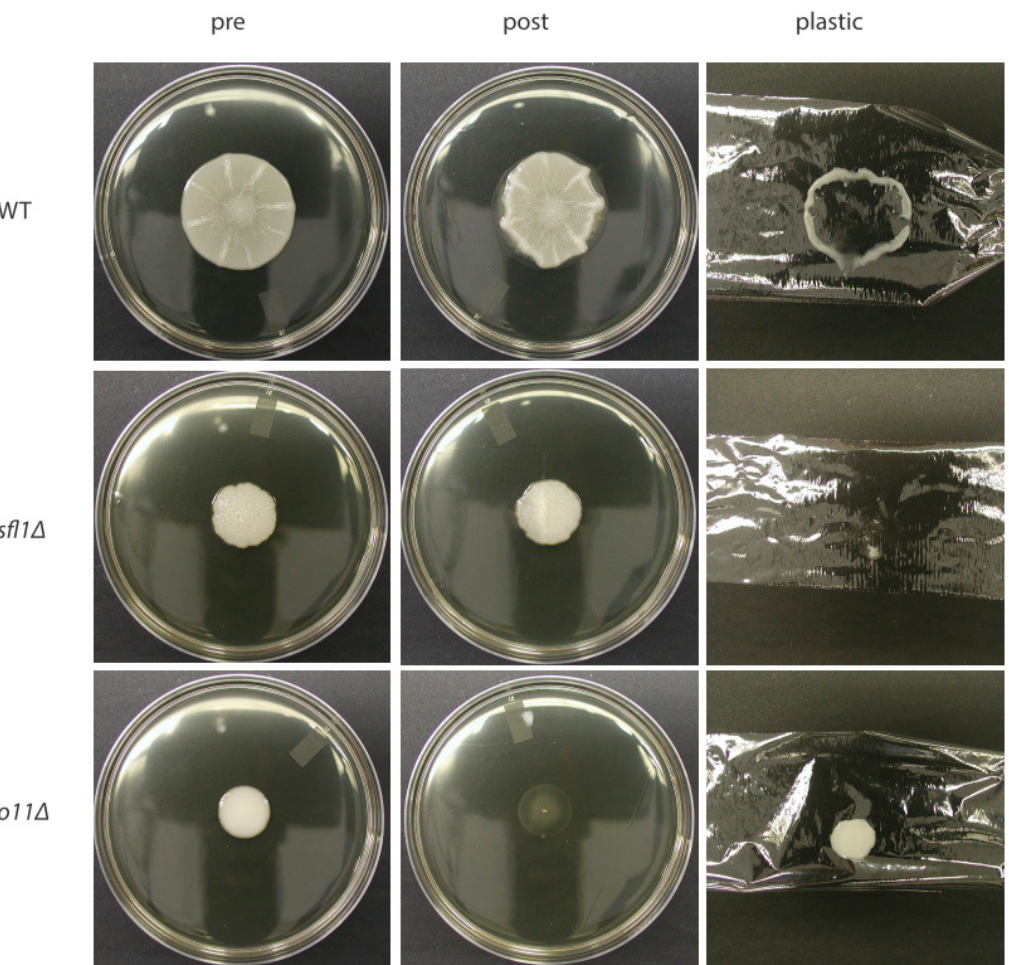
Figure 1. The sfl1 ∆ mutant stays attached to the agar in the overlay adhesion assay and does not form a rim and hub like the wild-type, whereas the flo11 ∆ - mutant does not adhere at all. Cells were grown for several days at ~25 °C on plates made with YPD and 0.3% agar. Then, plastic wrap is placed over the mat and removed. Cell growth prior to the assay is shown in the “pre” panels. Cells left on the agar following the assay are shown in the “post” panels. Cells that were removed with the plastic wrap are shown in the “plastic” column. WT = wild-type.